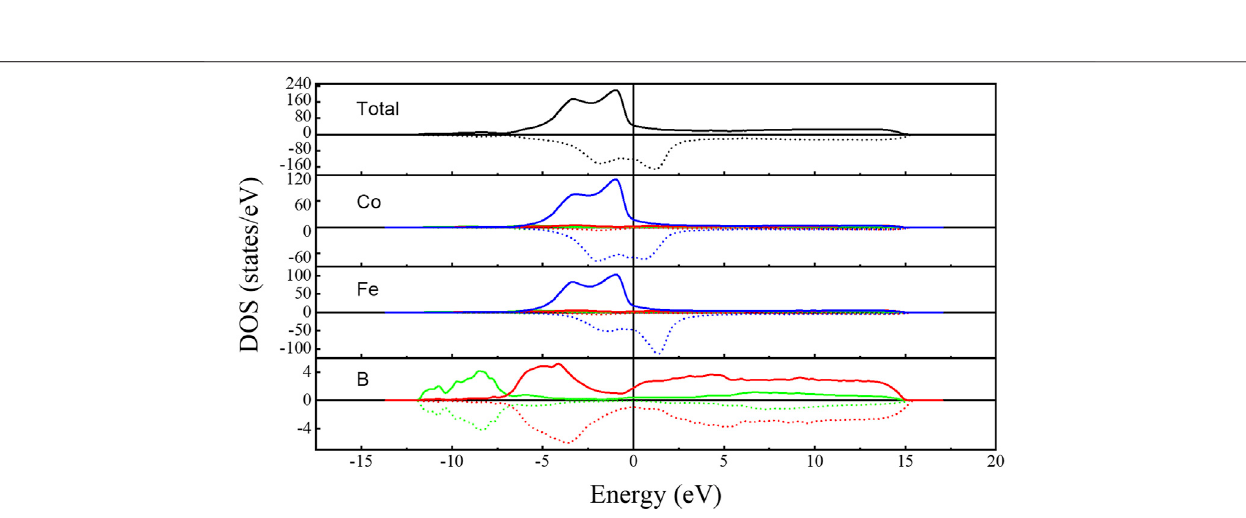
FIGURE7| Total(theblackcurves)andpartialDOSofCo-Fe-Bmetallicglass.Thegreen,red,andbluecurvesrepresentthe s , p ,and d orbitals,respectively.Solid lines and dotted lines represent the spin-up and spin-down. The vertical line indicates the Fermi level.